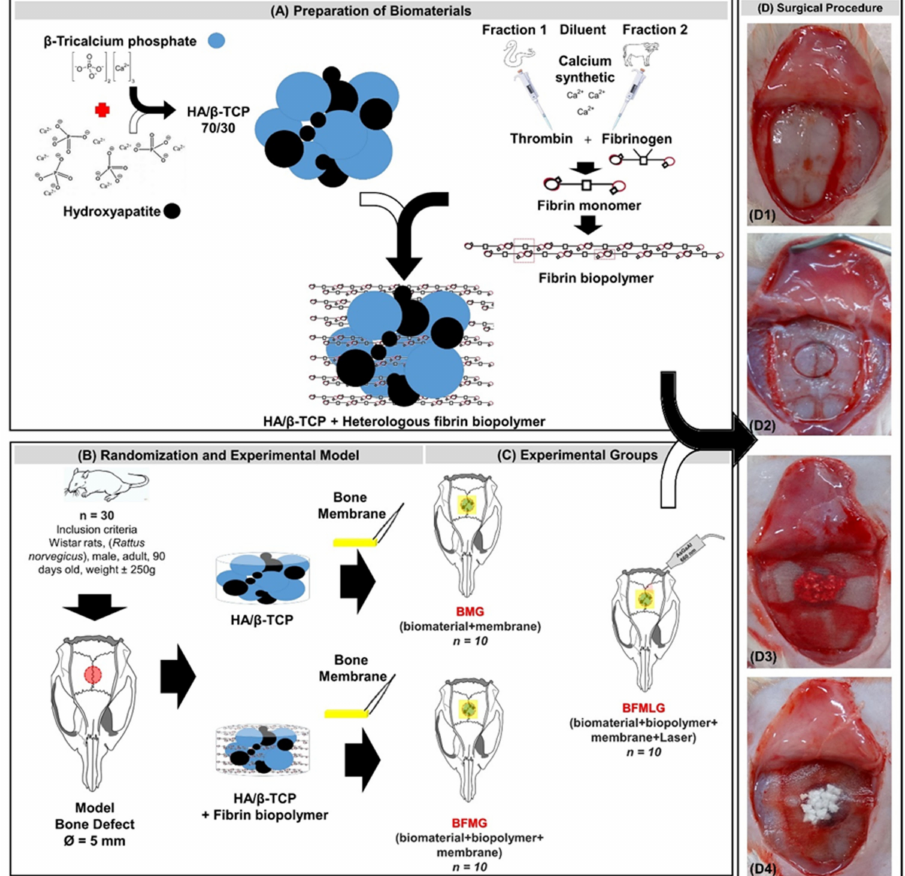
Figure 7. Schematic drawing of the experimental design. ( A ) Preparation of biomaterials: alloplastic hydroxyapatite and beta tricalcium triphosphate in the ratio of 70:30 (HA/ β -TCP 70/30). Heterologous fibrin biopolymer—fraction 1 (thrombin- like or gyroxin), diluent (synthetic calcium), fraction 2 (buffalo fibrinogen). HA/ β -TCP association and heterologous fibrin biopolymer. ( B ) Randomization and experimental model: 30 male adult Wistar rats. Experimental model—5 mm bone defect in the center of the parietal bones. ( C ) Experimental groups: BMG ( n = 10), defects filled with HA/ β -TCP and covered by a membrane; BFMG ( n = 10), defects filled with the association of HA/ β -TCP and fibrin biopolymer, covered by a membrane; BFMLG ( n = 10), defects filled with the association of HA/ β -TCP and fibrin biopolymer, covered by a membrane and PBMT. ( D ) Surgical procedure: ( D1 ) Parietal exposure. ( D2 ) Defect in the center of the parietal bones. ( D3 ) Defect filled with HA/ β -TCP and heterologous fibrin biopolymer. ( D4 ) Bone defect filled with HA/ β -TCP and heterologous fibrin biopolymer covered by a membrane derived from the bovine bone